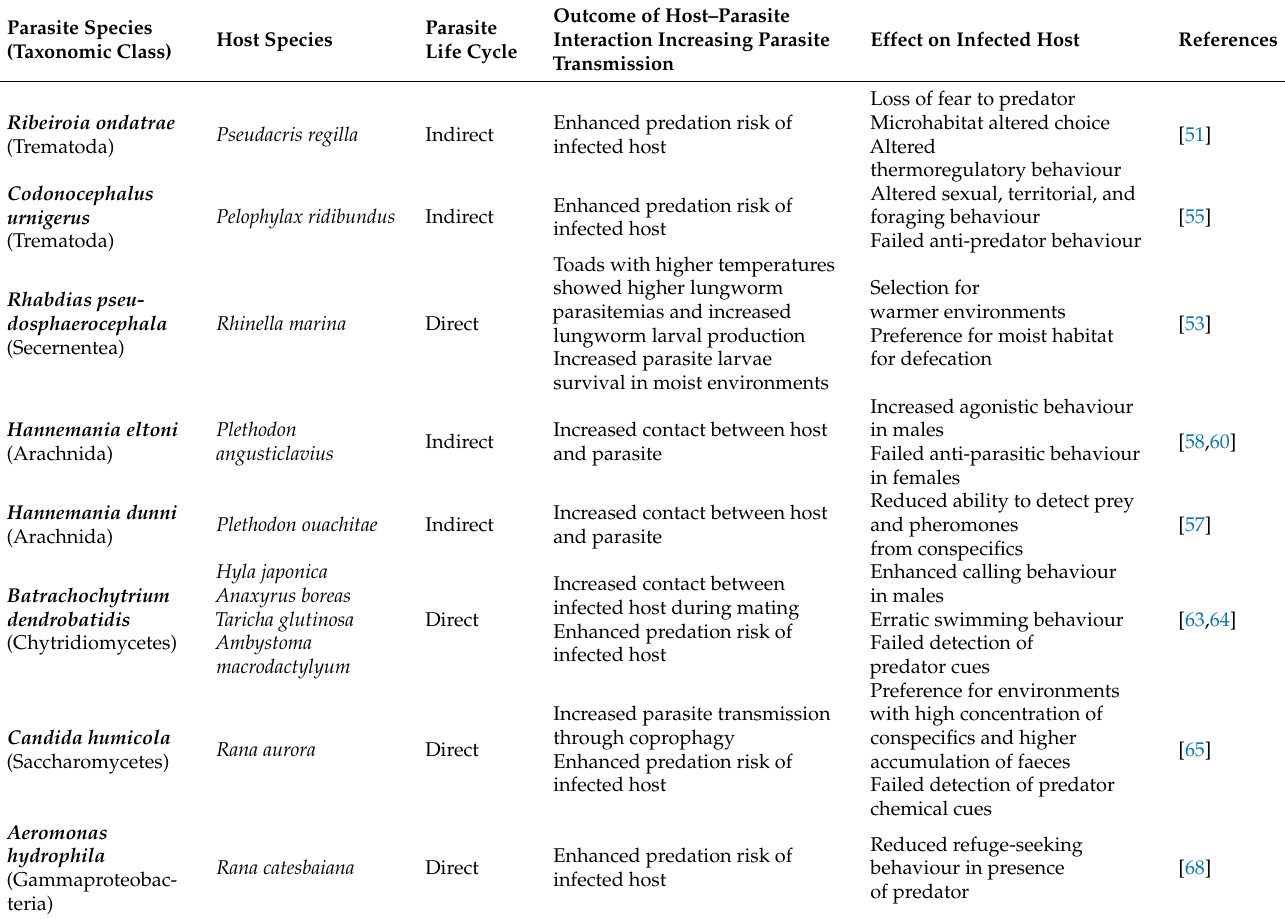
Table 1. Summary of studies reporting behavioural manipulations in several amphibian hosts induced by parasites from different